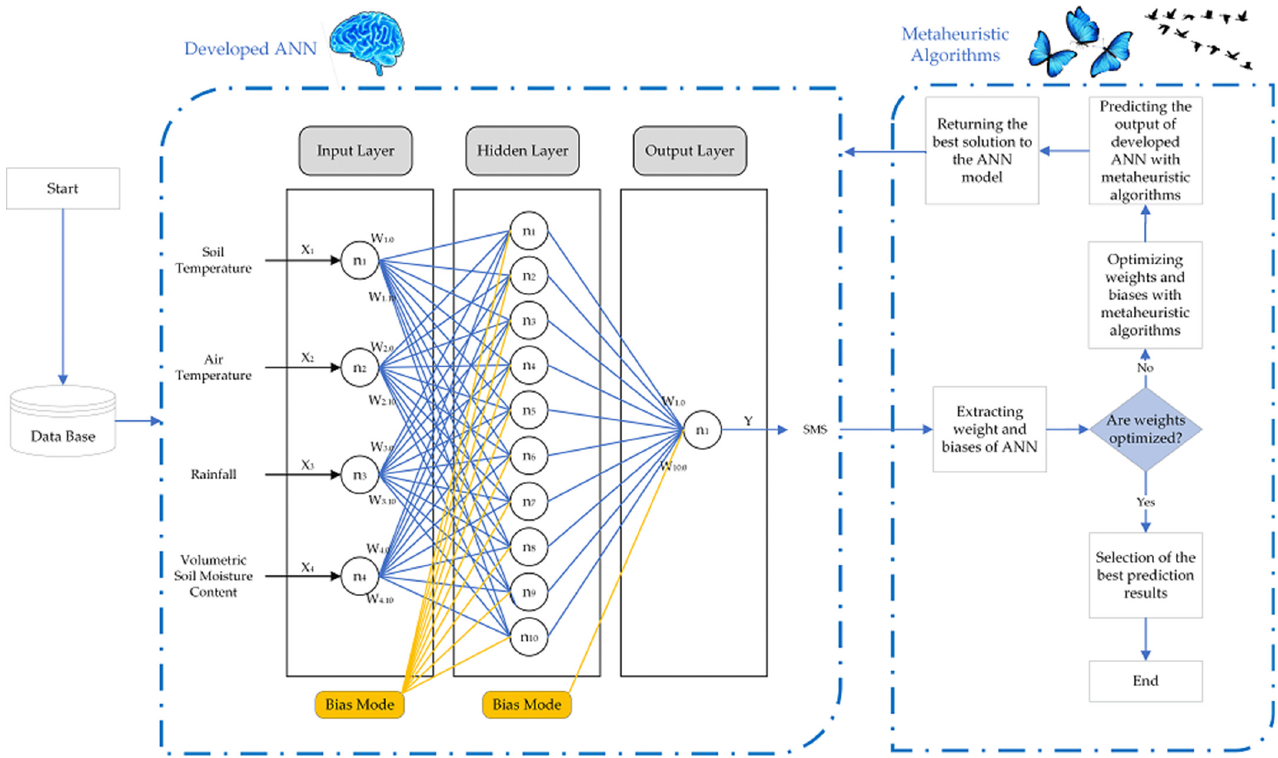
Figure 7. The modeling procedure of the hybrid PSO-ANN and BOA-ANN flowchart.